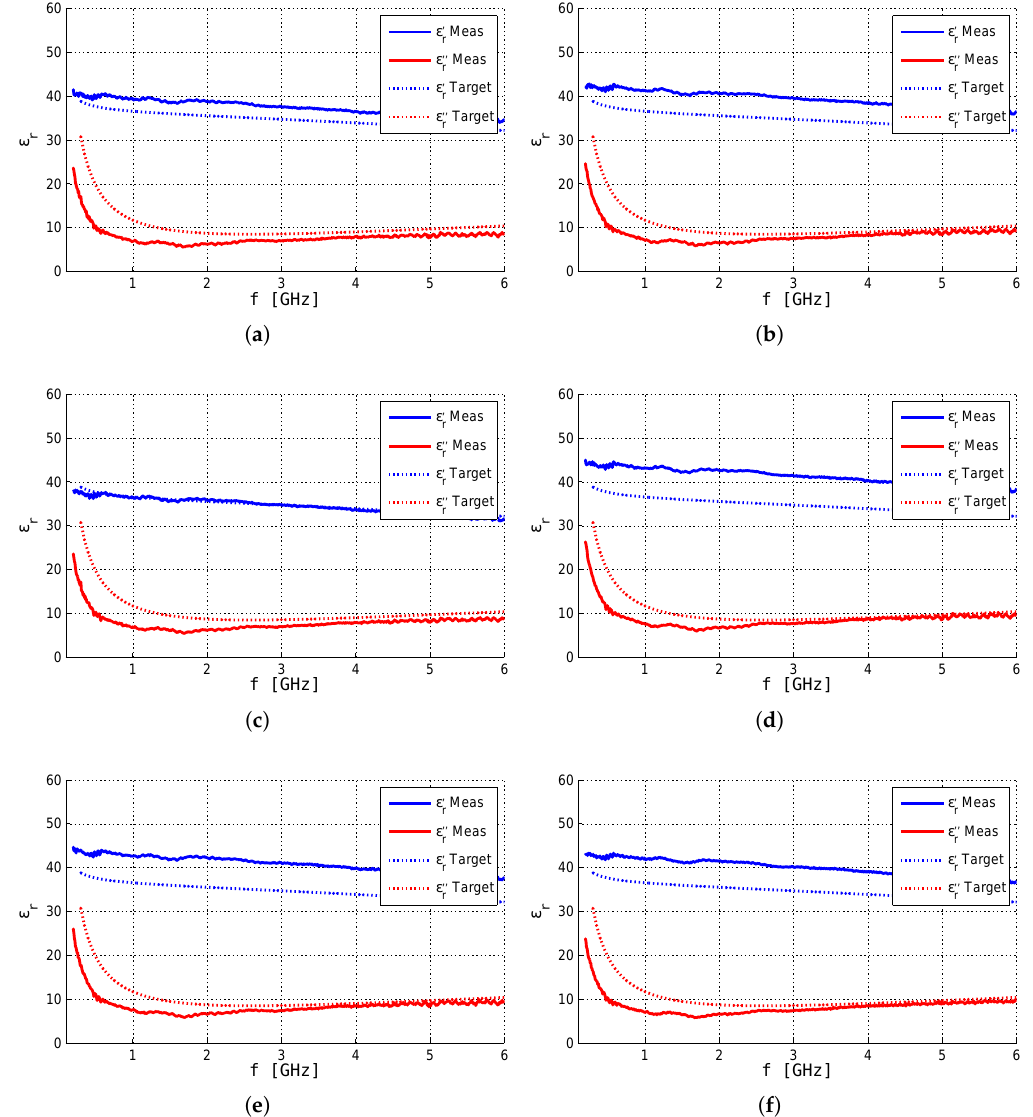
Figure 12. Measured and expected relative permittivity of the phantom samples. ( a ) Sample 1